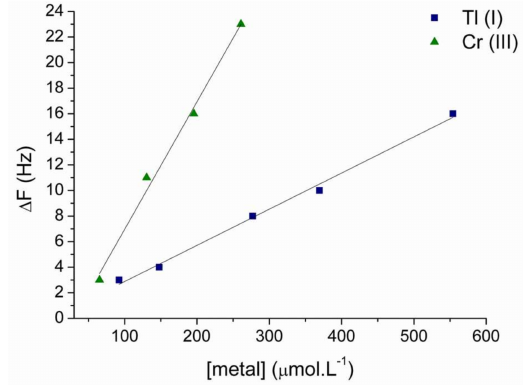
Figure 6. Response of the sensor based on NCTPP-Pr + to: Tl + (blue) and Cr 3+ (green).